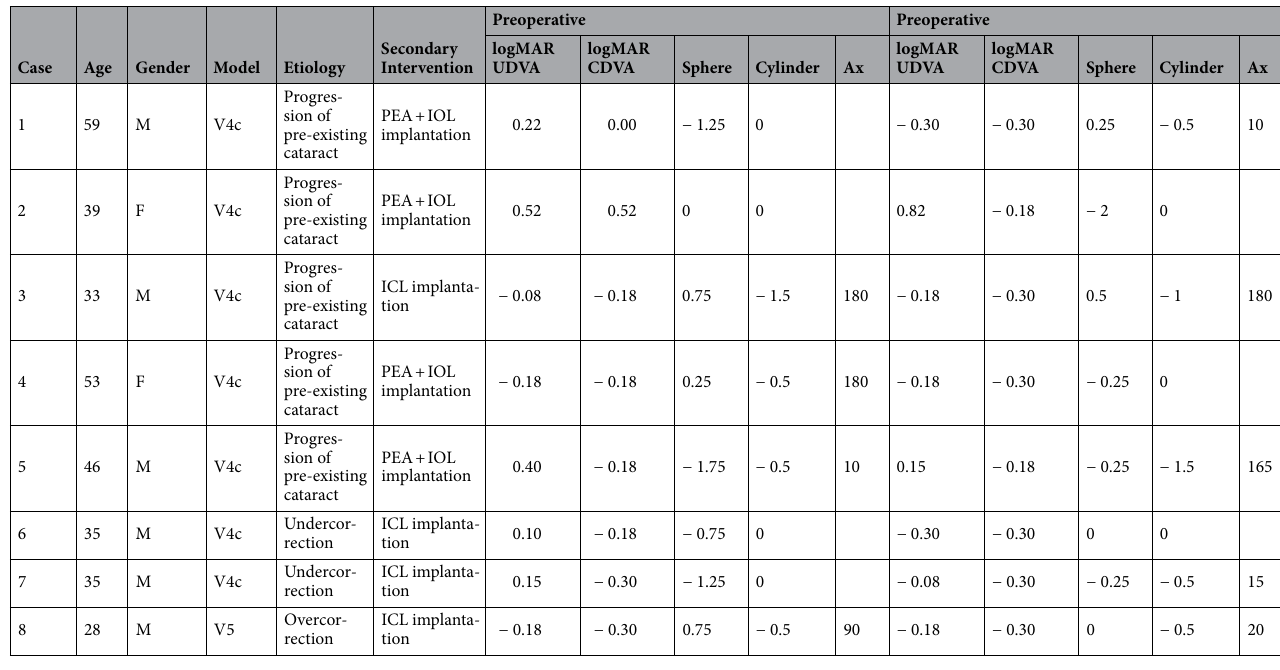
Table 1. Preoperative and postoperative demographics of the study population requiring implantable collamer lens (ICL) extraction. M male, F female, PEA phacoemulsification, IOL intraocular lens, ICL implantable